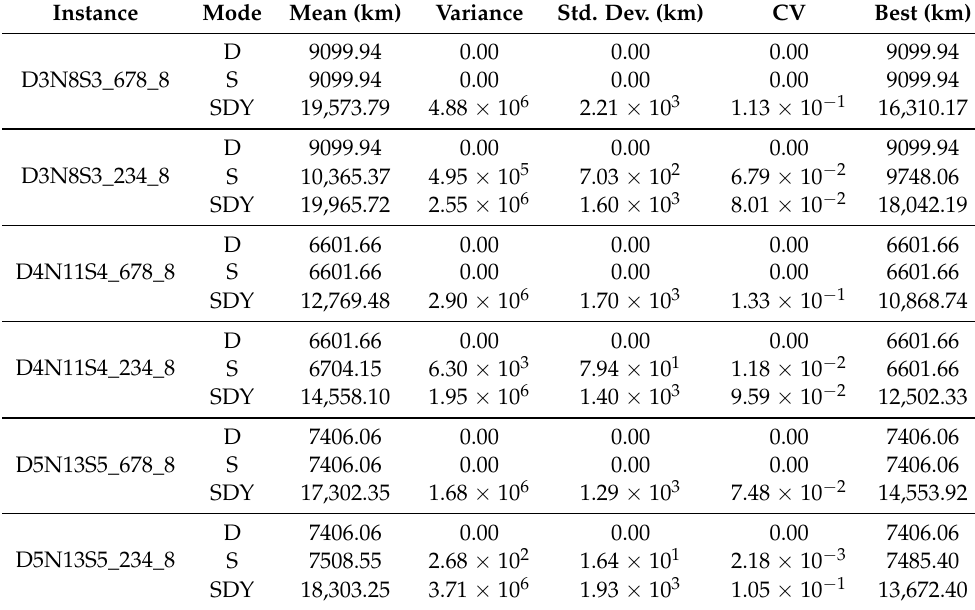
Table 8. Results of Total Distance Travelled with (Maximum) 8